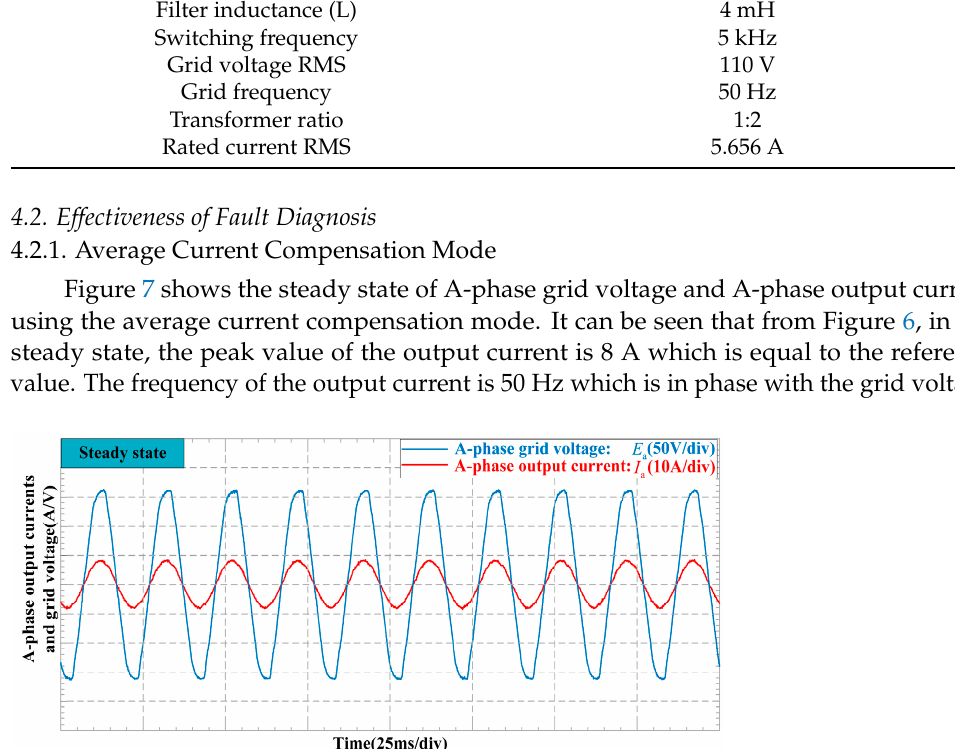
A = Figure 8. System dynamic response. ( a ) D − axis reference current and actual current ( b ) Error be- tween d − axis reference current and actual current ( c ) Three phase output current. 4.2.2. Fault Diagnosis Results A total of 27 types of three-phase current sensor offset faults are set in Table 2. Con- sidering the offset fault, this is a random constant [24,25]. Therefore, to verify the gener- alization of the proposed method, the fault conditions of different offsets are set. Each phase current sensor is set with two offsets: a positive offset of 20% of the amplitude of the original signal and a negative offset of 10% of the amplitude of the original signal. Through the combination of three-phase fault conditions, 6 single-phase offset faults, 12 two-phase offset faults, and 8 three-phase offset faults can be set.